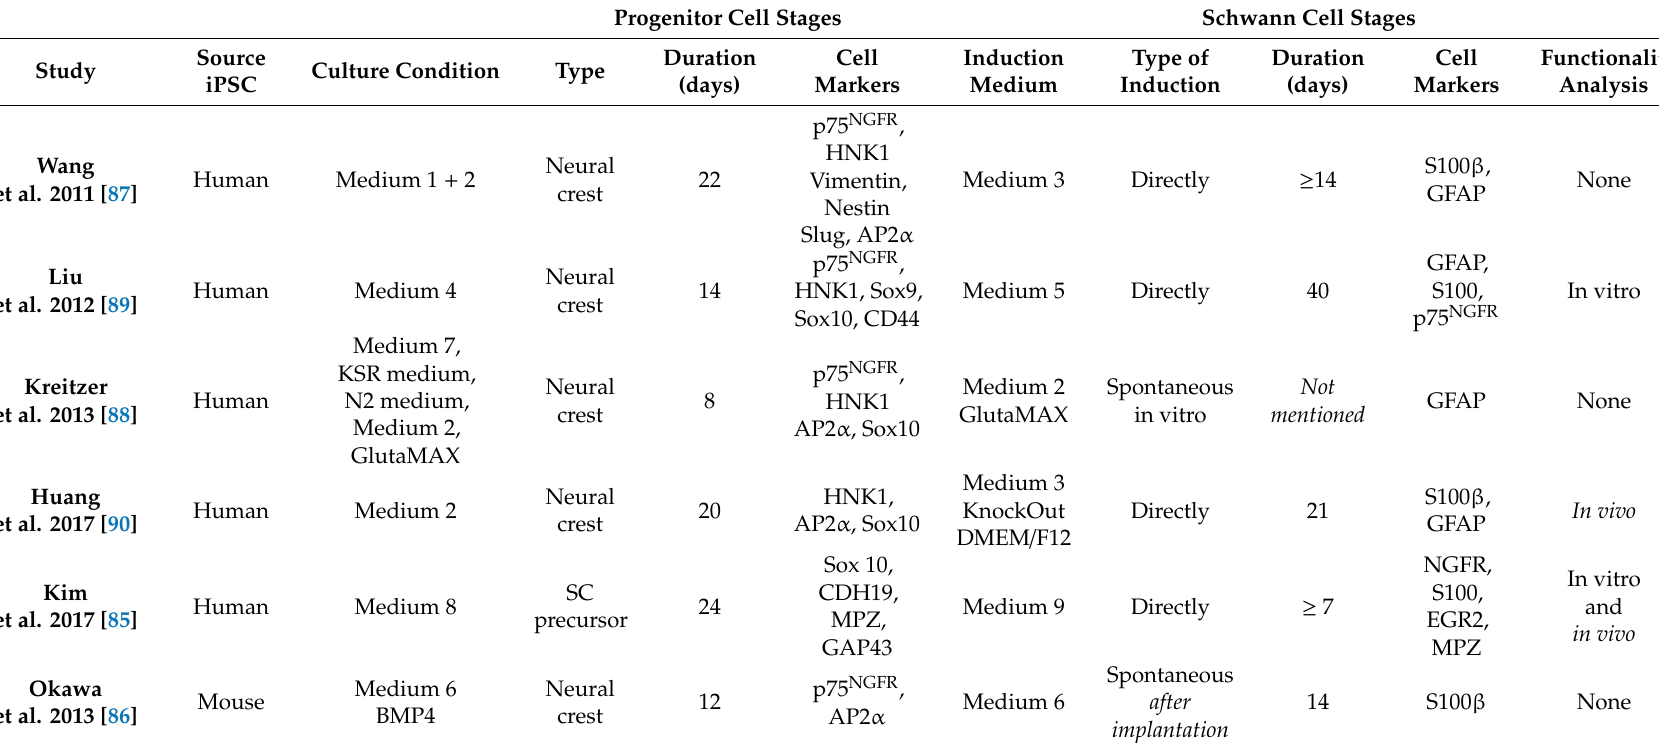
Table 2. Summary of induced pluripotent stem cells (iPSC) to Schwann cells (SC) di ff erentiation protocols. The table can be split between the progenitor cell stages (columns 3–6) and the Schwann cell stage (columns 7–11). The key markers used to identify the di ff erentiated cell types include common Schwann cell markers such as Sox10, GFAP, S100 β , and p 75NGFR as well as neural crest cell markers AP2 and Slug. Information on whether the di ff erentiation from the progenitor to the SC stage was direct or spontaneous is included in column 8. If the Schwann cells’ functionality was tested can be seen in the very right column (In vitro: myelinating culture with rat DRG neurons. In vivo : seeded in nerve guidance conduit in a rat sciatic nerve injury model). Only two studies [85,90] included in vivo testing of their iPSC-derived